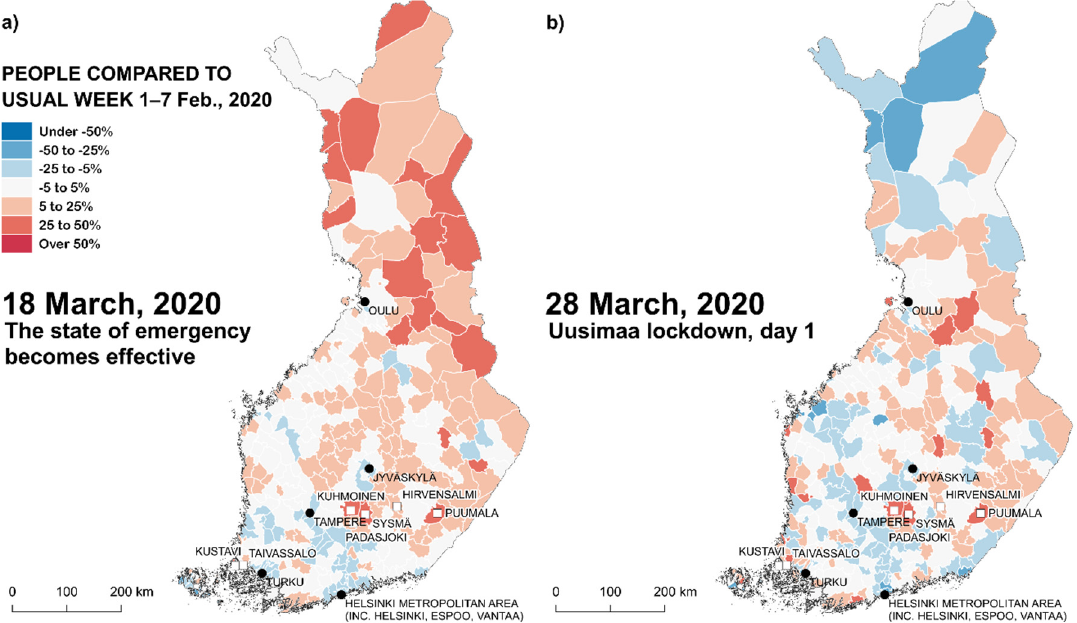
Figure 3. The relative change in the number of people spending time in the municipality on ( a ) 18 and ( b ) 28 March, 2020 compared to the baseline week. Black dots indicate the largest cities while the white squares indicate the mainland municipalities with the highest relative share of summer cottages.